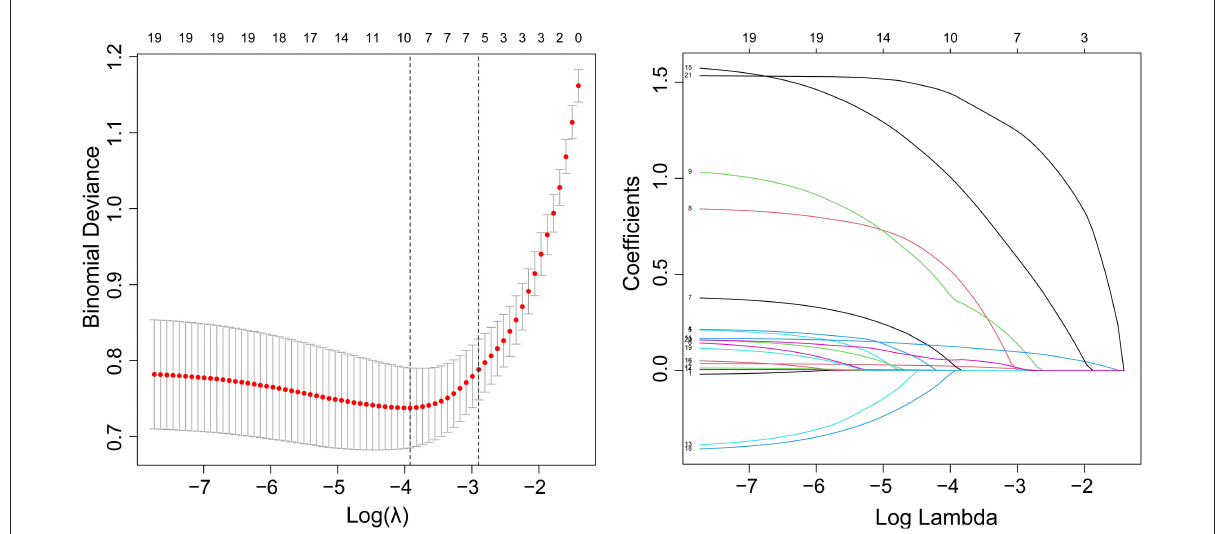
FIGURE1 Demographic and clinical feature selection using the LASSO binary logistic regression model. (A) Fivefold cross-validation of the LASSO model’s optimal parameter (lambda) was used. Plotted against log (lambda) is the partial likelihood deviance (binomial deviance). A minimum criteria and a 1 SE of the minimum criteria (the 1-SE criteria) were used to draw the dots representing the optimal values. (B) Profiles of the 21 features calculated by LASSO coefficients. This function plots coefficients vs. log (lambda) sequence. When lambda was optimal, there were nine features with non-zero coefficients, which was drawn as a vertical line. SE stands for standard error, and LASSO stands for least absolute shrinkage and selection operator.